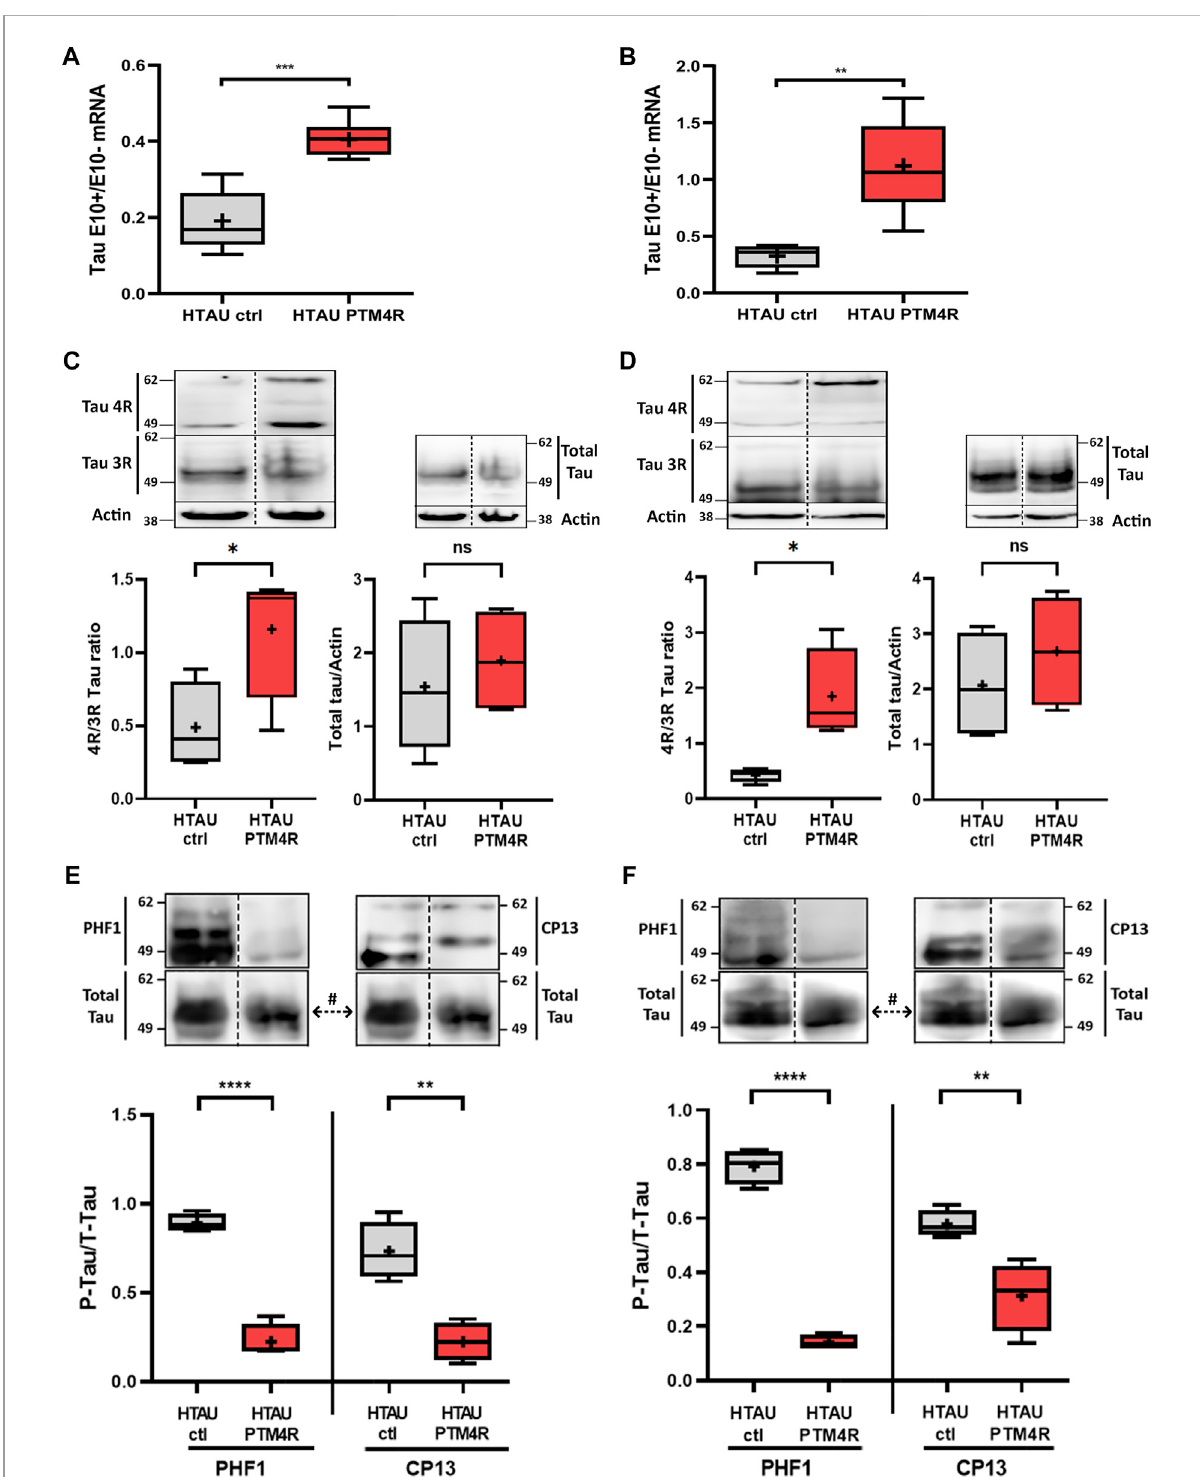
FIGURE 4 SMaRT rescue of Tau Isoforms and phosphotau contents in htau mice. (A , B) Relative content of tau isoforms determined by RT-qPCR with speci fi c primers for 3R (E10-) and 4R (E10+). Data are expressed as the isoform ratio (4R/3R) from mPFC (unpaired t-test, *** p < 0.001, htau control n = 5, htau PTM4R n = 7) and striatum (unpaired t-test, p ** < 0.01, htau control n = 5, htau PTM4R n = 5). (C , D) Western blot detection of tau protein contents in homogenates with 3R and 4R in control and PTM4R groups, and the comparison between both in total tau protein for both